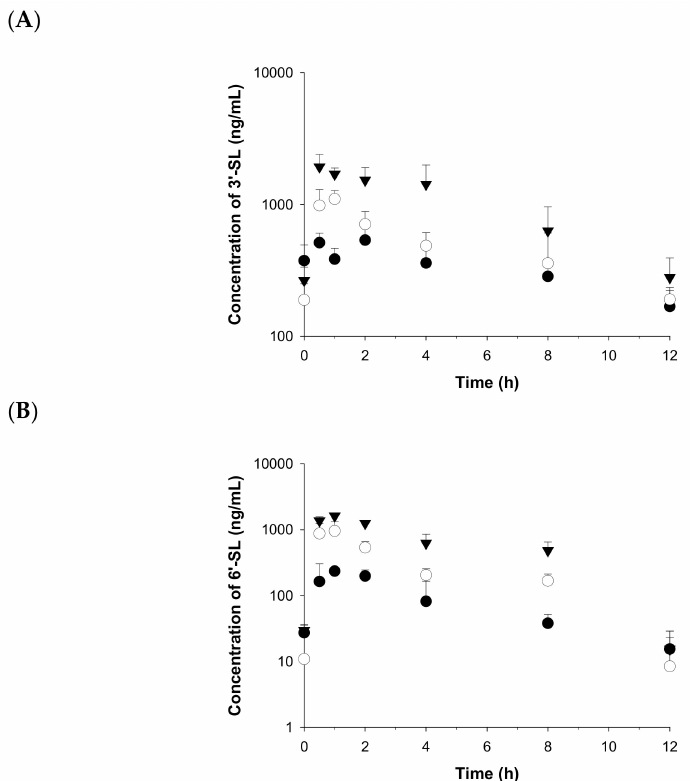
Figure 3. Temporal profiles of plasma concentration of ( A ) 3 (cid:48) -SL and ( B ) 6 (cid:48) -SL in rats, after intra- venous administration at doses of 100 ( • ), 500 ( mean ± SD of triplicate